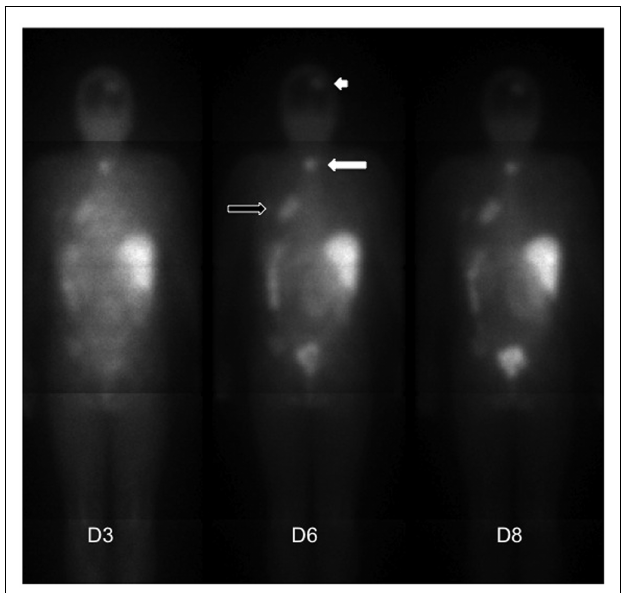
FIGURE 1 | Immunoscintigraphies (posterior view) recorded in a patient with a metastatic CEA-positive small cells lung cancer .This patient was injected with the anti-CEA hMN14x734 bispecific antibody and a therapeutic activity of 131 I-di-DTPA-indium.The immunoscintigraphies recorded 3, 6, and 8days after hapten injection showed a good uptake in lung (black arrow), mediastinum (white arrow), and brain (white arrowhead)